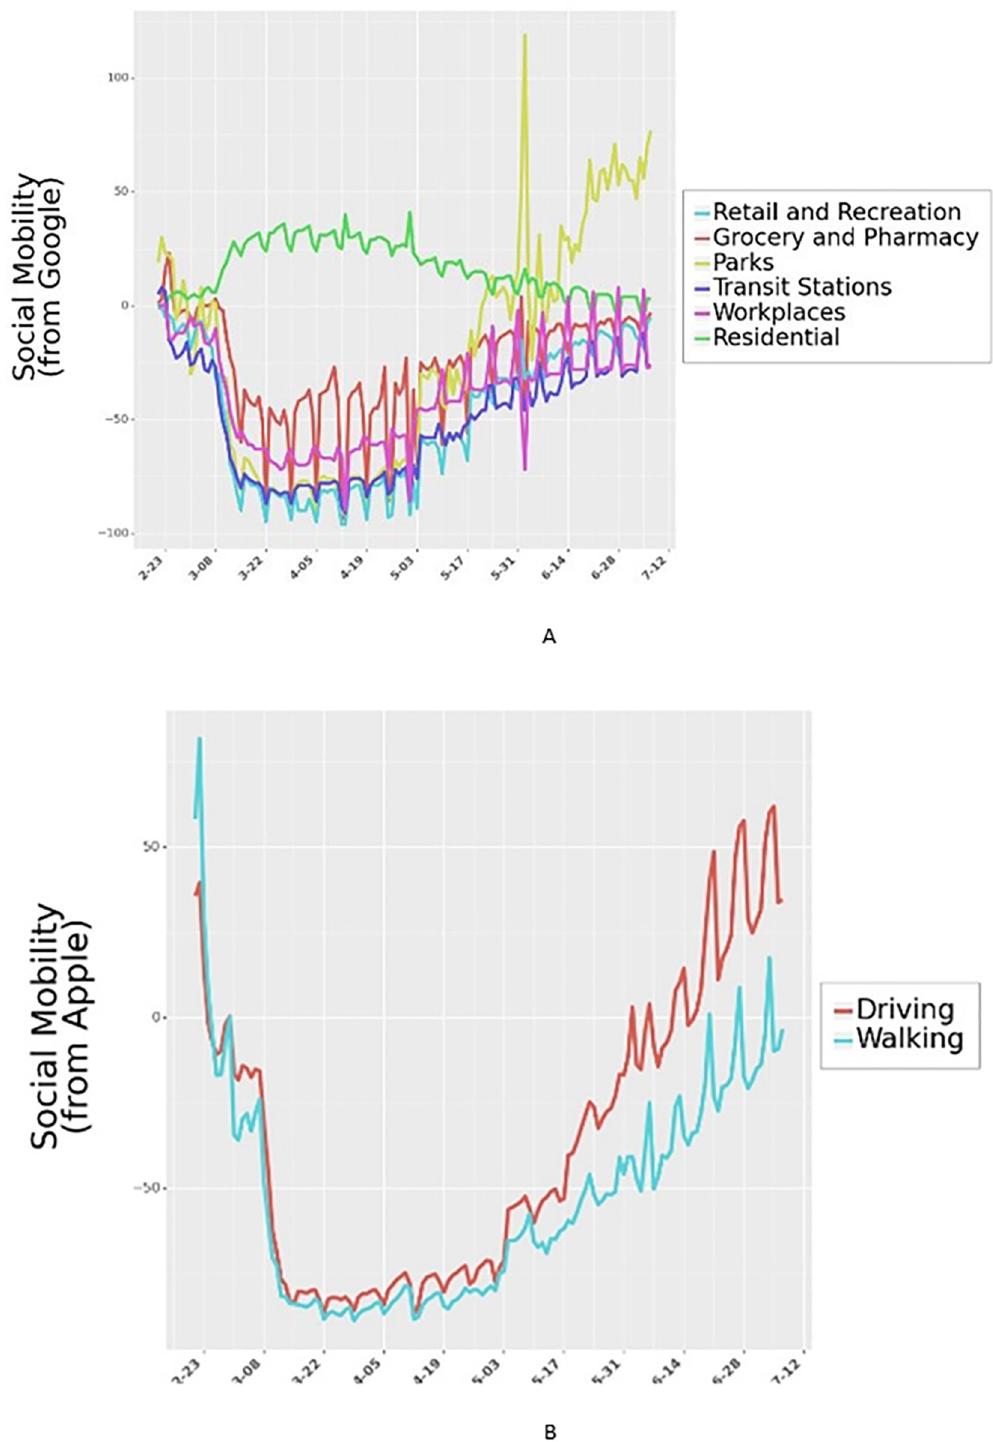
Fig 2. Outdoor mobility from Google Mobility Reports and Apple Mobility Reports for Italy. Outdoor mobility for all 24 countries is shown in Fig H in S1 Text.